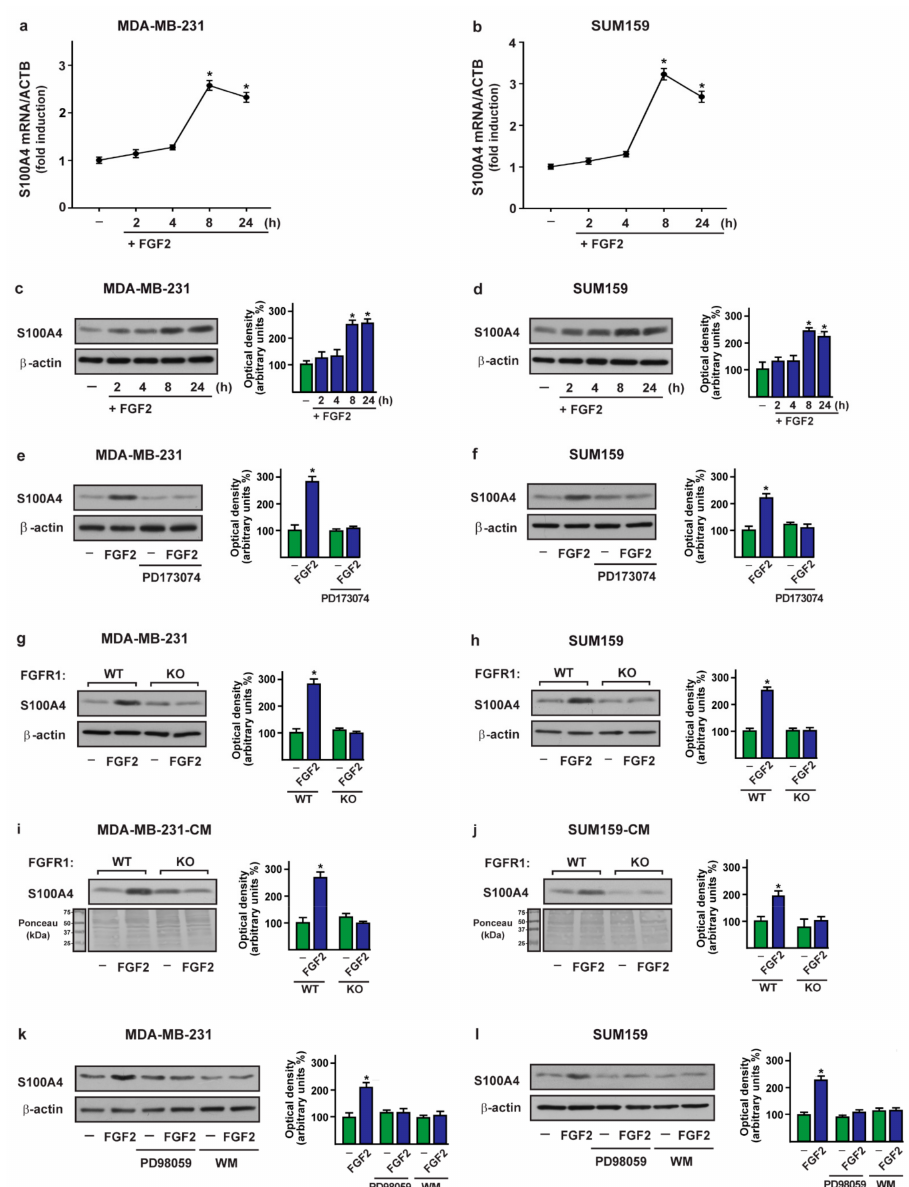
Figure 2. The FGF2/FGFR1 transduction pathway upregulates S100A4 expression in MDA-MB-231 and SUM159 cells. mRNA ( a , b ) and protein ( c , d ) expression of S100A4 evaluated respectively by real-time PCR and immunoblotting in MDA-MB-231 and SUM159 cells treated with vehicle (-) and 25 nM FGF2, as indicated. In RNA experiments, values were normalized to the β -actin (ACTB) expression and shown as fold changes of S100A4 mRNA expression upon FGF2 treatment compared to cells exposed to vehicle (-). ( e , f ) Immunoblots showing S100A4 protein expression in MDA-MB-231 and SUM159 cells exposed for 8 h to 25 nM FGF2 alone and in combination with 1 µ M FGFR1 inhibitor PD173074. ( g , h ) S100A4 protein expression evaluated by immunoblotting in FGFR1 (WT) and FGFR1 (KO) MDA-MB-231 and SUM159 cells treated for 8 h with vehicle (-) and 25 nM FGF2, as indicated. ( i , j ) Evaluation by immunoblotting of S100A4 levels in conditioned medium (CM) collected from FGFR1 (WT) and FGFR1 (KO) MDA-MB-231 and SUM159 cells treated for 8 h with vehicle (-) and 25 nM FGF2. Ponceau red staining of the membrane was used as a loading control for the CM. ( k , l ) Immunoblots showing S100A4 protein expression in MDA-MB-231 and SUM159 cells exposed for 8 h to vehicle (-) and 25 nM FGF2 alone and in the presence of 1 µ M MEK inhibitor PD98059 or 100 nM PI3K inhibitor Wortmannin (WM). β -Actin served as a loading control. Side panels show densitometric analysis of the blots normalized to the loading control. Values represent the mean ± SD of three independent experiments. (*) indicates p <